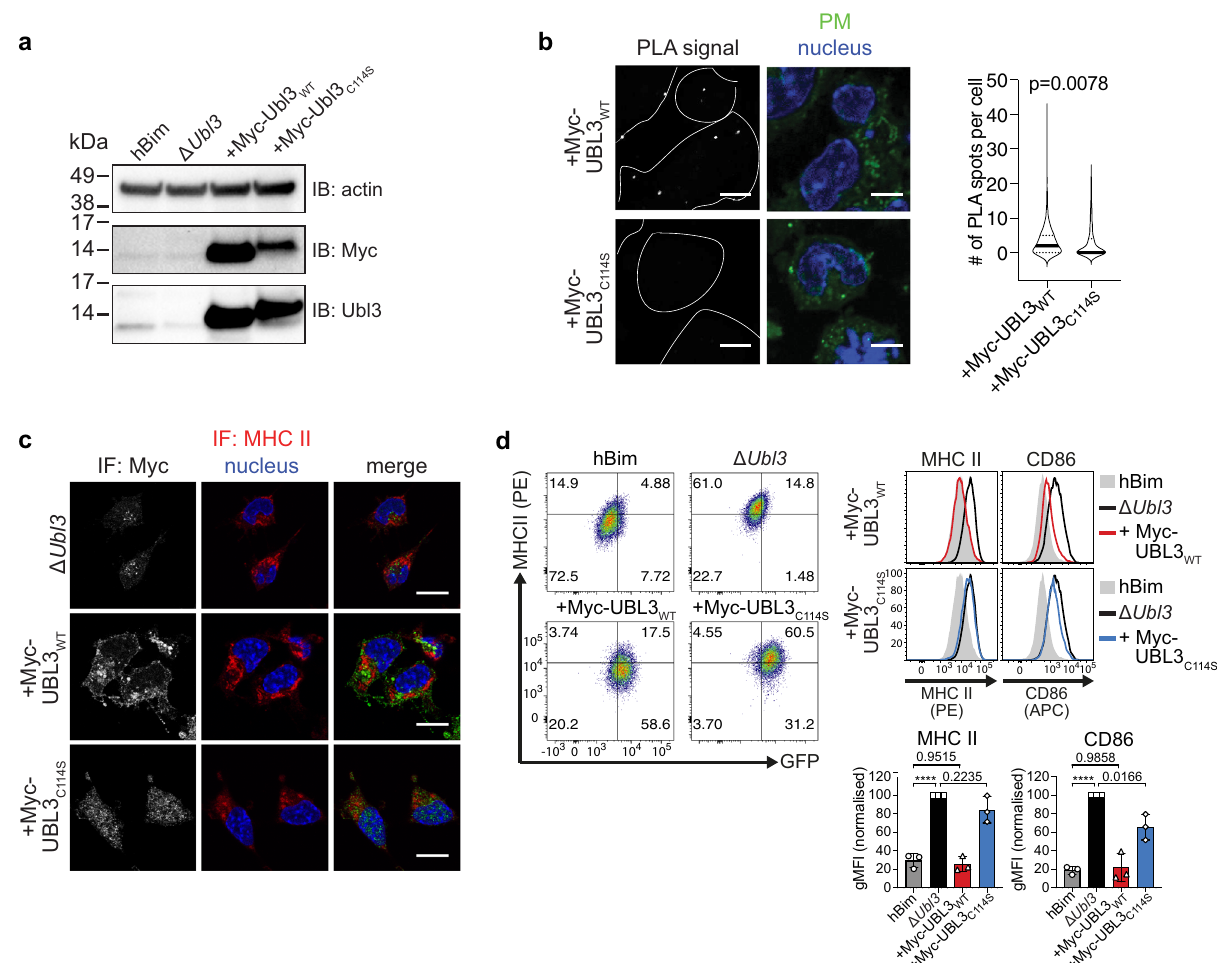
Fig. 3 UBL3 regulation of MHC II and CD86 requires membrane anchoring. a – d Clonal Δ Ubl3 MutuDCs were retrovirally transduced with Myc-tagged wild type UBL3 ( “ + Myc-UBL3 WT ” ), or UBL3 C114S mutant ( “ + Myc-UBL3 C114S ” ). a Post-nuclear supernatants of 2.5 × 10 5 cells were analyzed by non- denaturing SDS-PAGE and western blotting using anti-actin (20-33) anti-Myc (71D10) and anti-Ubl3 (ab113820) antibodies. Representative blot is shown for two independent experiments with similar results. b Proximity ligation assay (PLA). Δ Ubl3 MutuDC expressing Myc-UBL3 WT or Myc-UBL3 C114S were stained with plasma membrane (PM) CytoPainter. After washing, fi xing, and permeabilization, cells were stained with Hoechst 33342, rabbit anti-MHC II (JV2) antiserum, and mouse anti-Myc mAb (9E10) and subjected to PLA. Scale bar = 10 µ m. PLA spots indicate spatial proximity between MHC II and UBL3 and were enumerated within plasma membrane boundaries (violin plots). One experiment, P value as indicated, unpaired Welch ’ s t test (two-sided). c Immuno fl uorescence microscopy. Cells were fi xed, permeabilized, and stained with biotinylated rat anti-MHC II mAb (M5/114), mouse anti-Myc mAb (9E10), streptavidin Alexa Fluor 647, donkey anti-mouse Alexa Fluor 594, and 0.5 μ g/ml DAPI. Scale bar = 10 µ m. Representative image shown for two independent experiments with similar results. d Flow cytometry analysis of MHC II and CD86. Left: Dot plots show MHC II ( x axis) and GFP ( y axis). Center: histograms show corresponding expression levels of MHC II or CD86, with gray solid histogram: control MutuDCs expressing non-targeting hBim gRNA; black line: Δ Ubl3 MutuDCs, red line: Δ Ubl3 MutuDCs expressing Myc-UBL3 WT , blue line: Δ Ubl3 MutuDCs expressing Myc-UBL3 C114S . Right: quanti fi cation of gMFI from three experiments, normalized to highest gMFI of each experiment, with bars mean ± SD and symbols. **** P < 0.0001, one-way ANOVA with Bonferroni ’ s